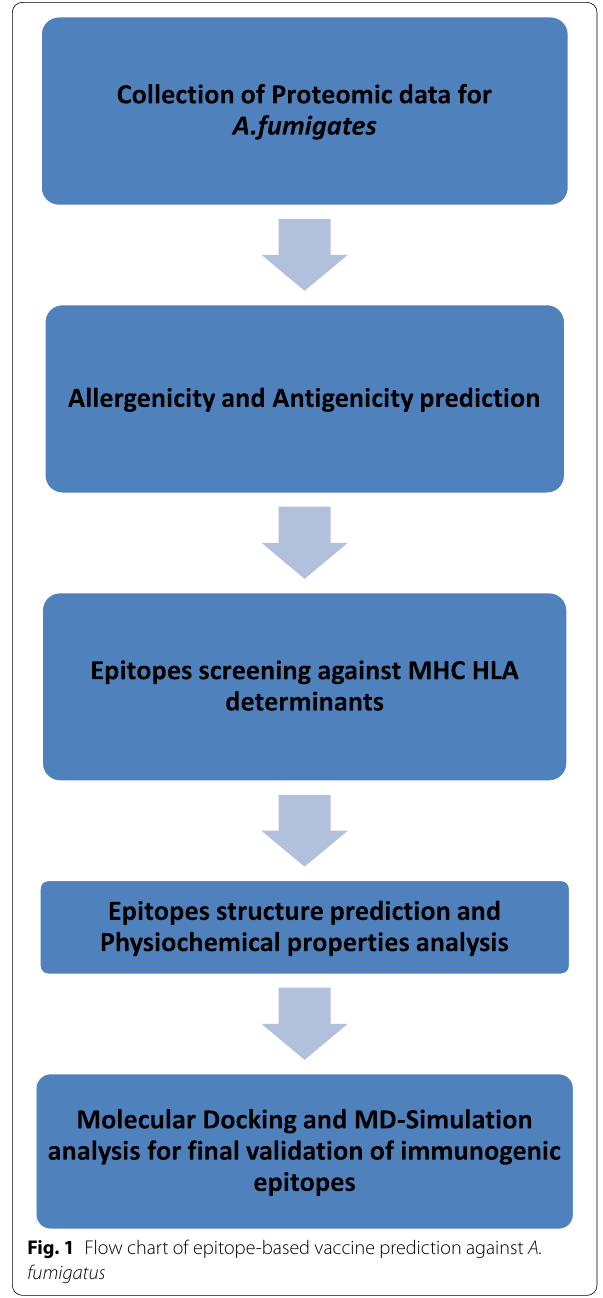
Fig. 1 Flow chart of epitope-based vaccine prediction against A. fumigatus